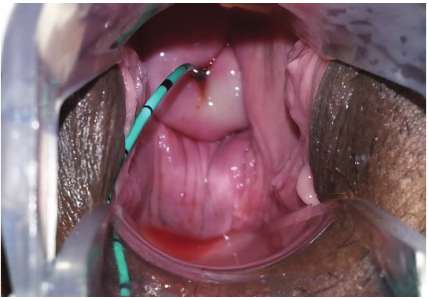
Figure 1: Fluid outflow consistent with hematuria from external os on cervical speculum examination.